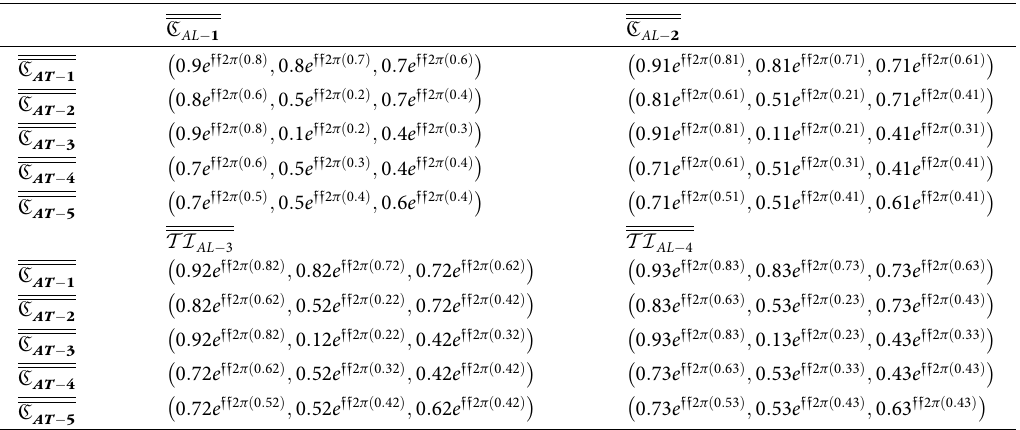
Original decision